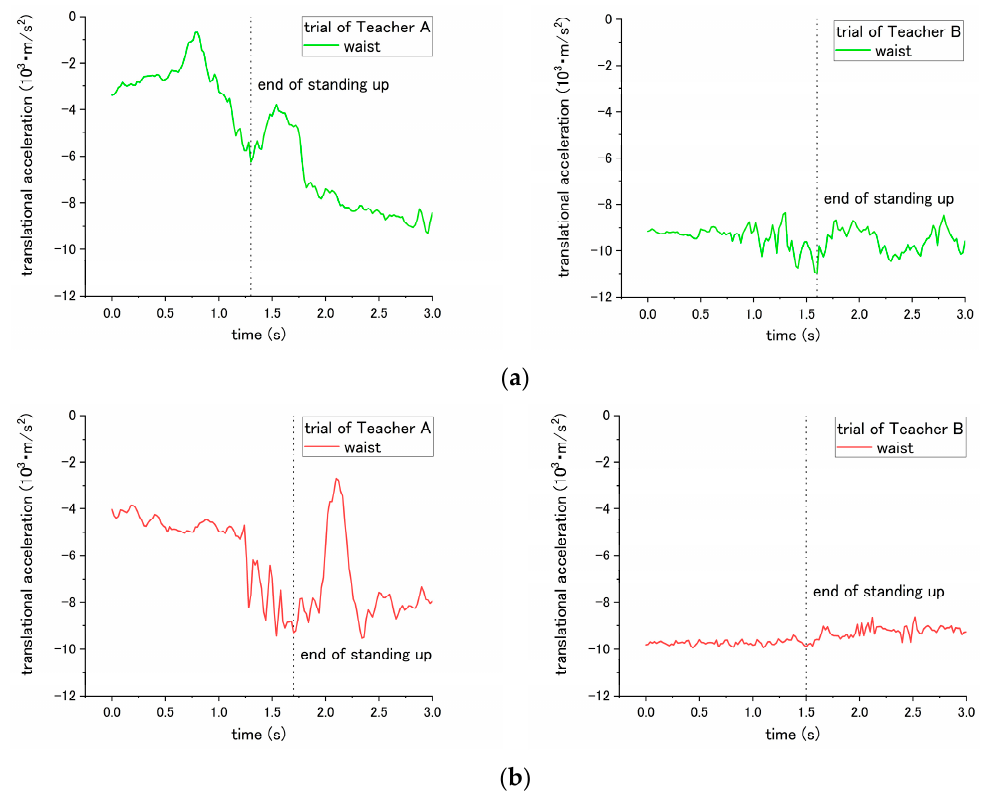
Figure 7. Translational displacement of patient’s waist during step No. 11 through ( a ) correct way, and ( b ) incorrect way conducted at step No. 10.